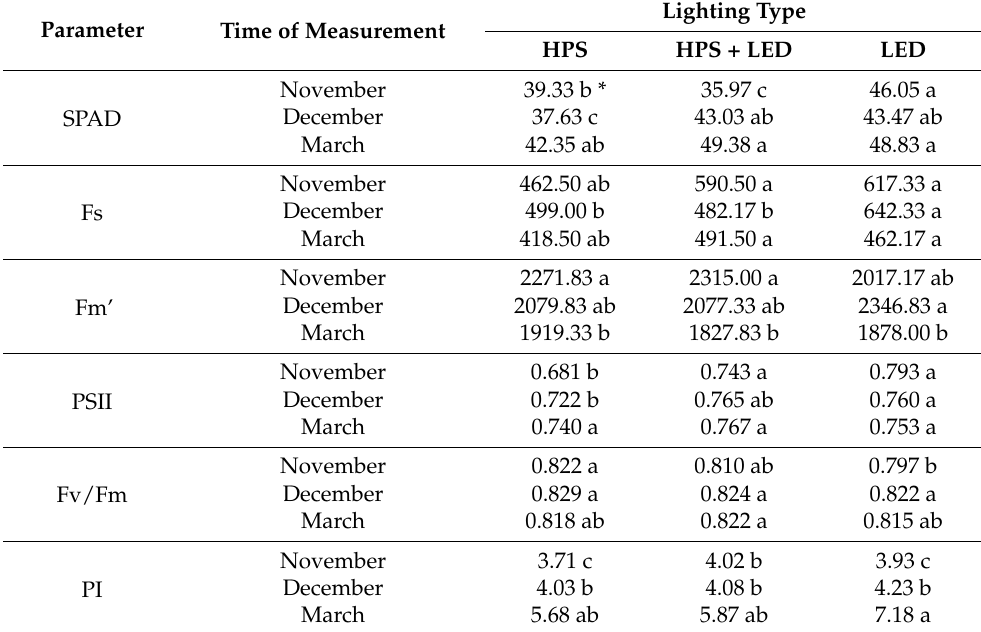
Table 2. Effect of lighting type and time of measurement on the value of the chlorophyll a fluorescence parameters and SPAD in young